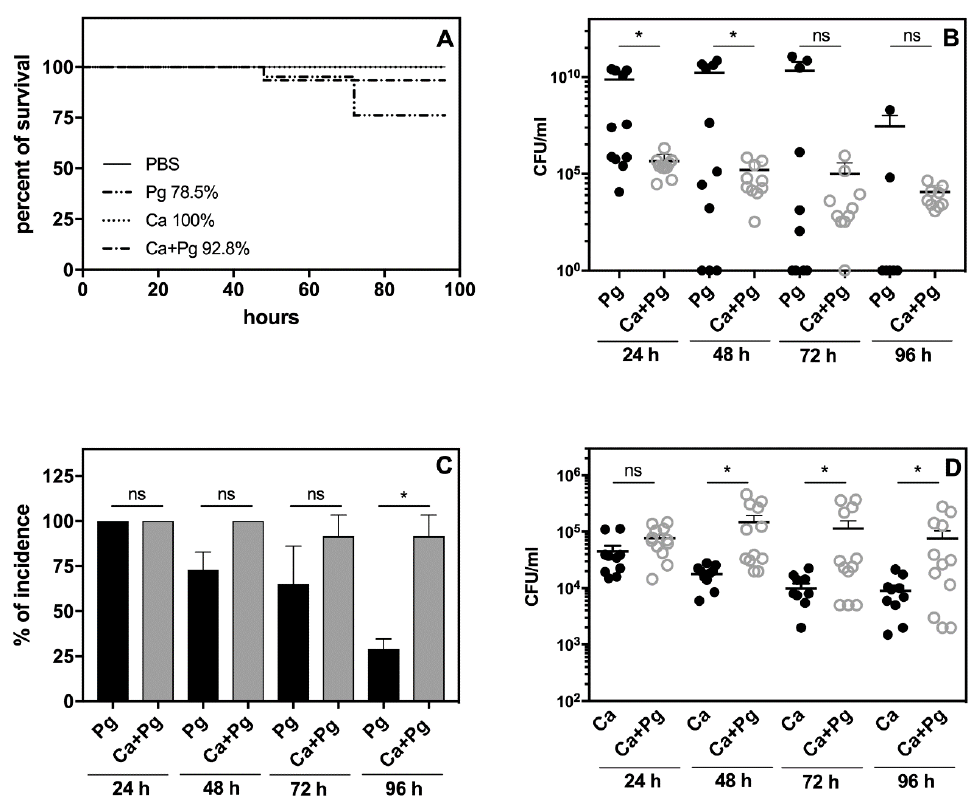
Figure 3. Changes in ( A ) mouse survival, ( B ) bacterial or ( D ) fungal viability, and ( C ) bacterial infection incidence in the subcutaneous chamber fluid. Mortality is expressed as a percentage and was zero in the control group. The graph depicts the mortality outcomes in the mice after bacterial (10 7 CFU in 0.1 mL PBS), fungal (10 5 CFU in 0.1 mL PBS) or mixed microbial exposure using a subcutaneous chamber model of infection. Subcutaneous chambers were initially inoculated with P. gingivalis , C. albicans or a mixture of these strains as described in the methods section. For control animals, we applied inoculation of the chambers with PBS. Recovery of viable bacteria or fungi from these chambers (CFU / mL) was determined by colony counting on agar plates following propagation at the conditions appropriate for the respective microorganism. Each dot represents a single animal. The data were collected from 2 sets of experiments. A Mann–Whitney U test ( n = 8 mice for each group, with 2 as references) was performed for statistical analysis. Bars represent the mean CFU / mL of 12 chambers and include a standard error of the mean. Asterisks denote statistical significance ( p > 0.1234 ns, * p ≤